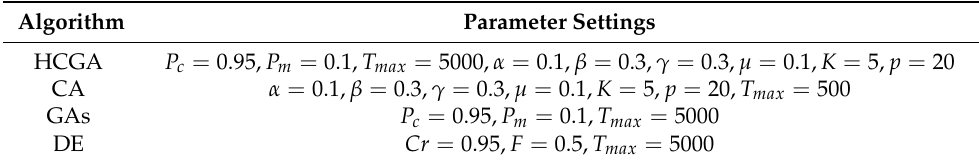
Table 6. Main parameters of the HCGA, GAs, CA and